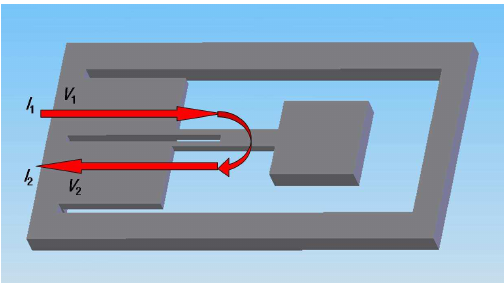
Figure 1. A schematic view of a piezoresistive accelerometer.